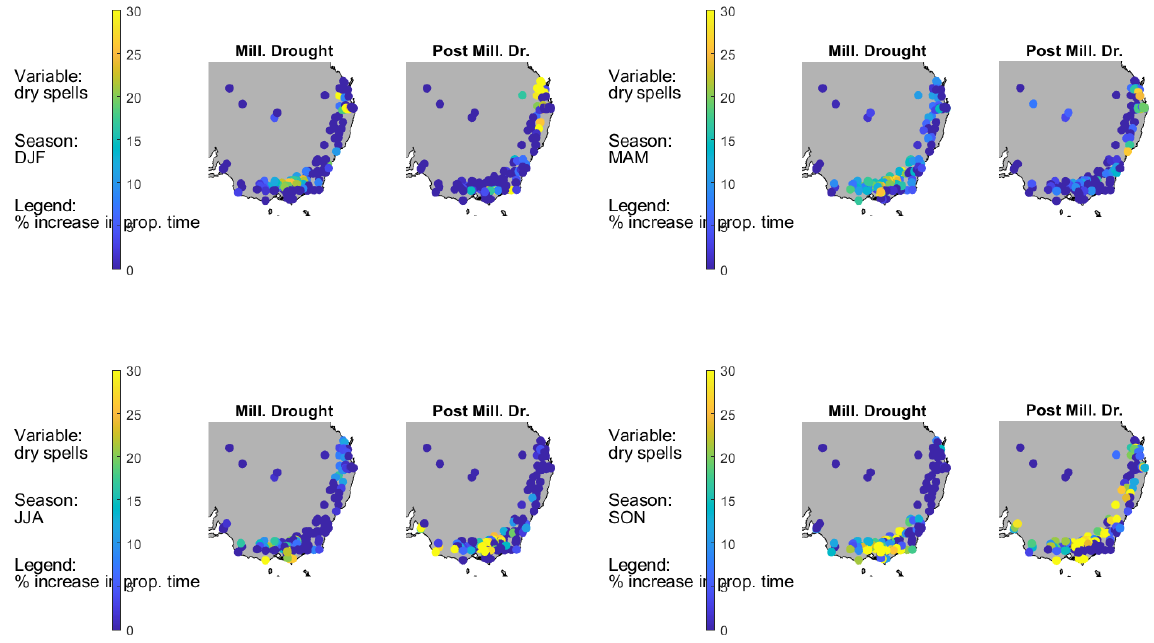
Figure D2. Same as Fig. D1 except for dry spells (see Fig. 3 for dry spell definition). Based on data from Fowler et al. (2021).